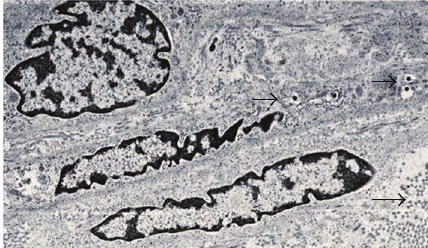
Figure 5: Electron micrograph of rhesus macaque kidney following sequential transplantation of E28 pig pancreatic primordia in mesentery and implantation of porcine islets in the kidney. Arrows: endocrine granules. Scale bar a 2um. Reproduced with permission from Organogenesis